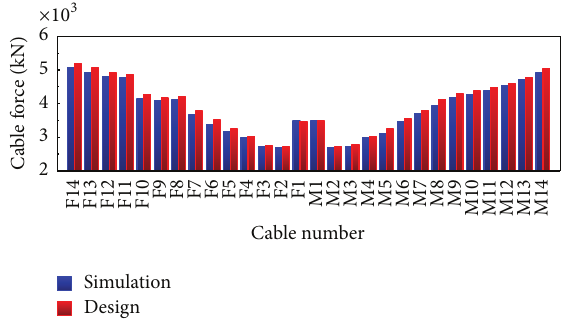
Figure 8: Comparison between design and simulated initial cable force of